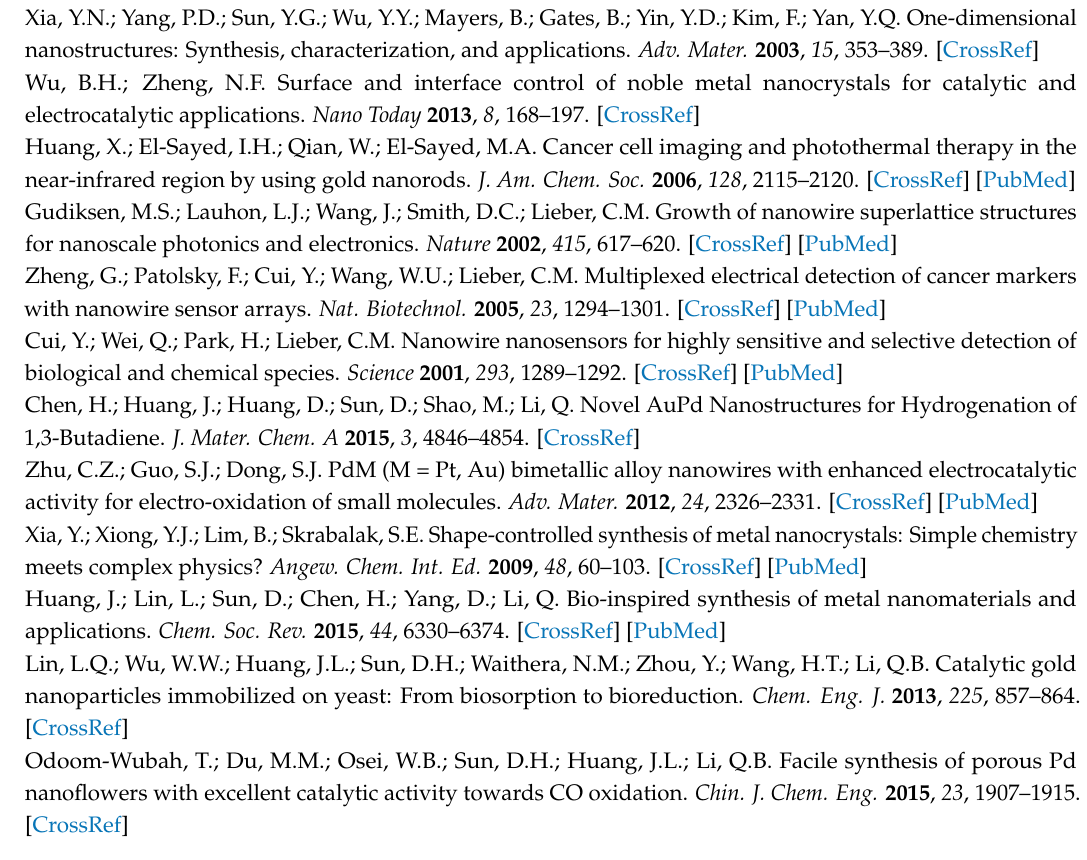
Figure S1: (A) SEM image of the Au-Ag NWs synthesized using Escherichia coli cells ( E. coli ) (B) absence of PPC, Figure S2: SERS spectra of (a) R6G (10 − 6 , 10 − 10 , 10 − 12 mol L − 1 ) and (b) MBA (10 − 5 , 10 − 6 , 10 − 7 mol L − 1 ) in water on Au-Ag NWs obtained at the laser wavelength of 632.8